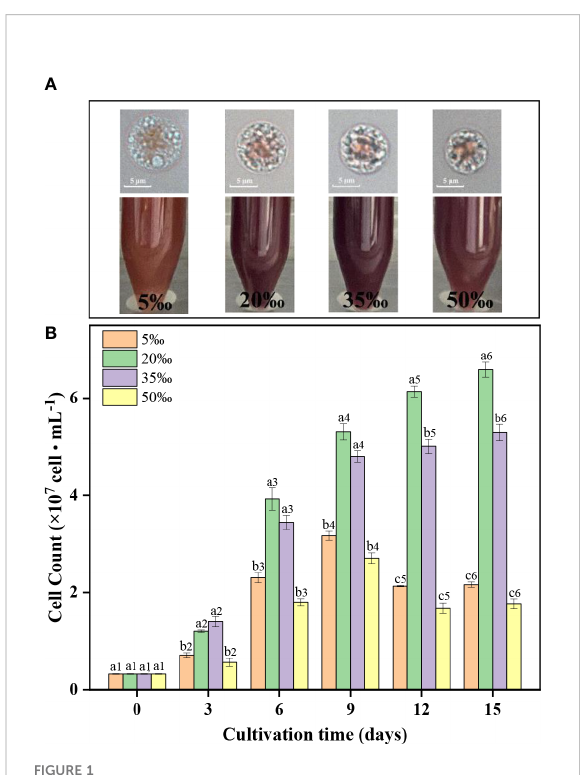
FIGURE 1 The cell morphology (A) and cell count (B) of Porphyridium purpureum FACHB 806 under different salinities. The values shown are the averages of two biological replicates and three technical replicates ± standard deviation. Different letters indicate signi fi cant differences (a1 – b1, day 0; a2 – b2, day 3; a3-b3, day 6; a4-b4, day 9; a5-c5, day 12; a6-c6, day 15).